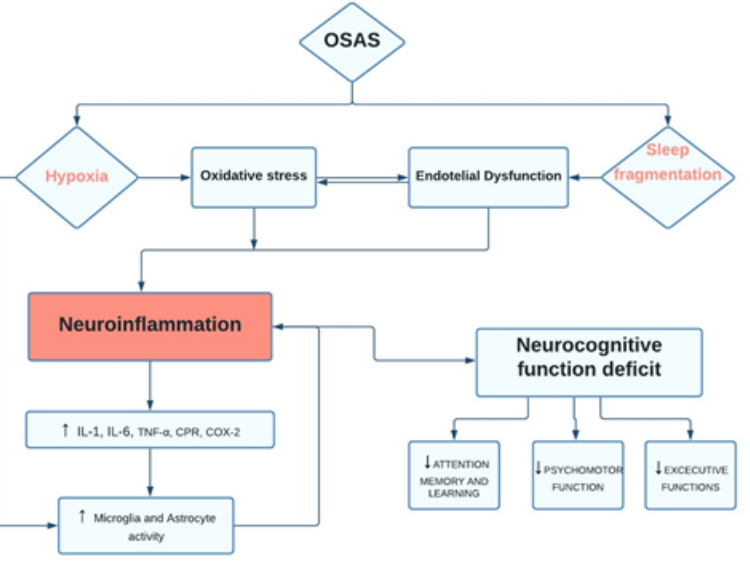
Figure 1. Flow-diagram. OSAS pathways and neurocognitive dysfunction.